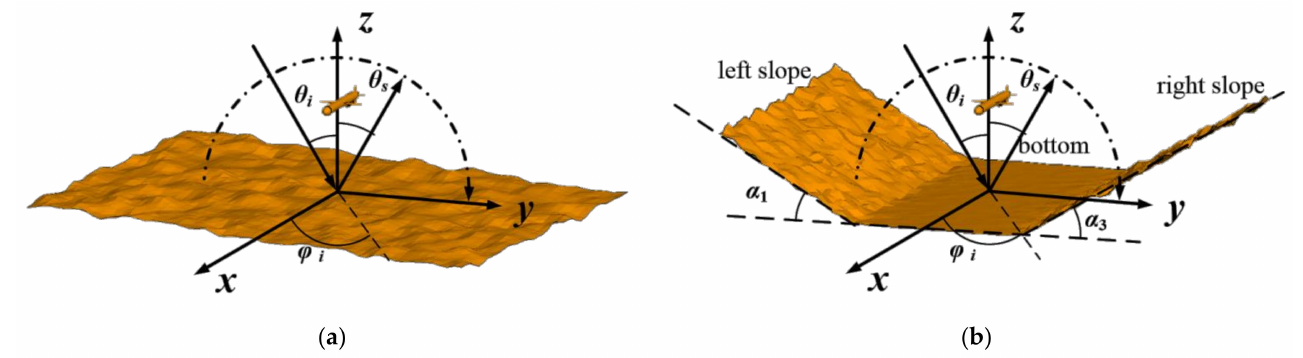
Figure 10. Illustration of a missile-like target above plain and valley composite rough surface: ( a ) target above plain; ( b ) target above valley.